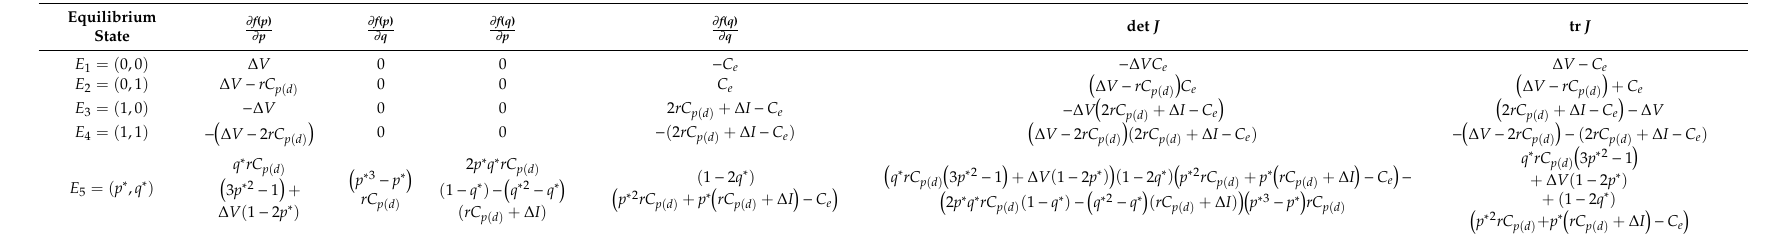
Table 6. Determinants and traces of the Jacobian matrix J for five potential ESSs under